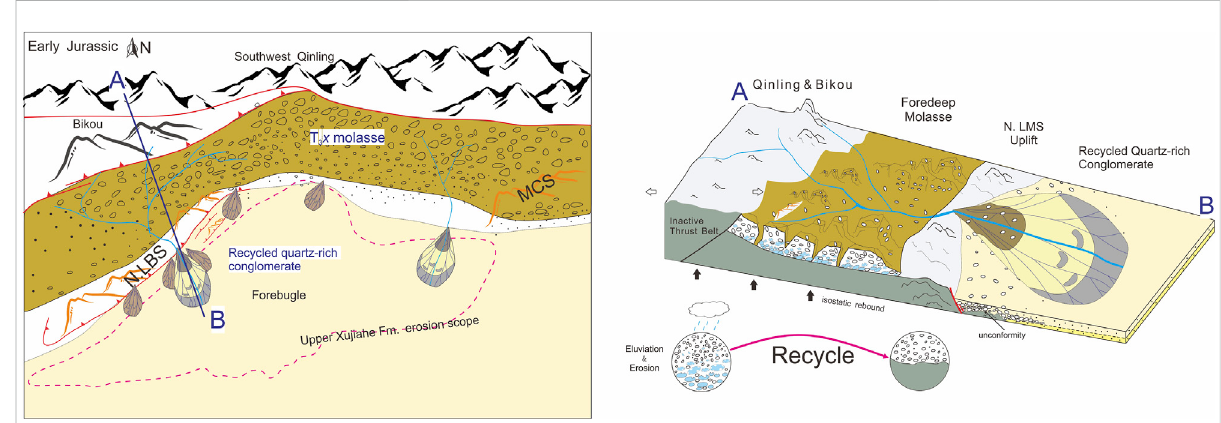
FIGURE 8 Depositional model of the QPC of the Lower Jurassic Baitianba Formation in the northern part of the Longmen Shan orogenic